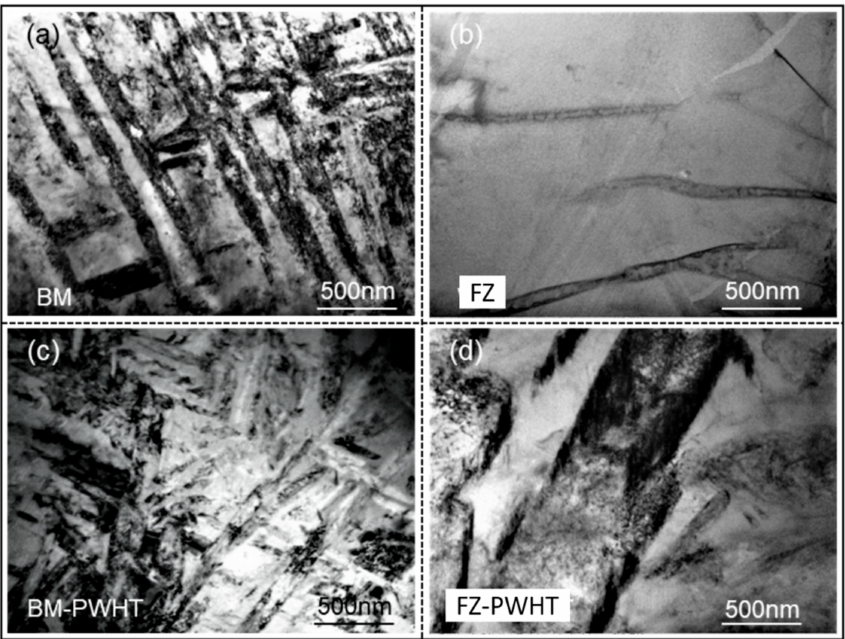
Figure 10. TEM observation on the precipitates of ( a ) BM, ( b ) FZ of as-welded Ti55531 joint, ( c ) BM after PWHT and ( d ) FZ of as-welded Ti55531 joint after